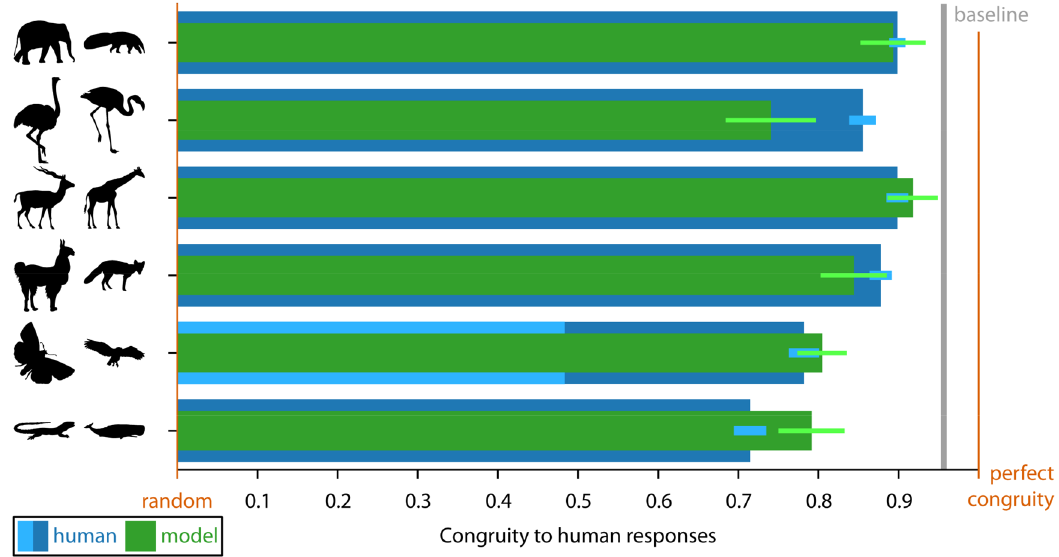
Figure 9. Human results and semantic organization model for Experiment 1. We plot response congruity on a continuum between random (0.0: congruity between responses of random model) and perfect congruity to human responses (1.0: all responses on top of each other). Horizontal bars plot congruity and standard errors for human responses (dark blue) and for the semantic organization model (green), separately for each pair of shapes. For the Butterfly–Owl pair, we also report congruity when measured across the two response types (light blue bar, see text for explanation). Finally, we plot the congruity of human responses in the baseline condition with the two pairs of identical shapes (Whale–Whale and Antelope–Antelope) as reference (grey bar).